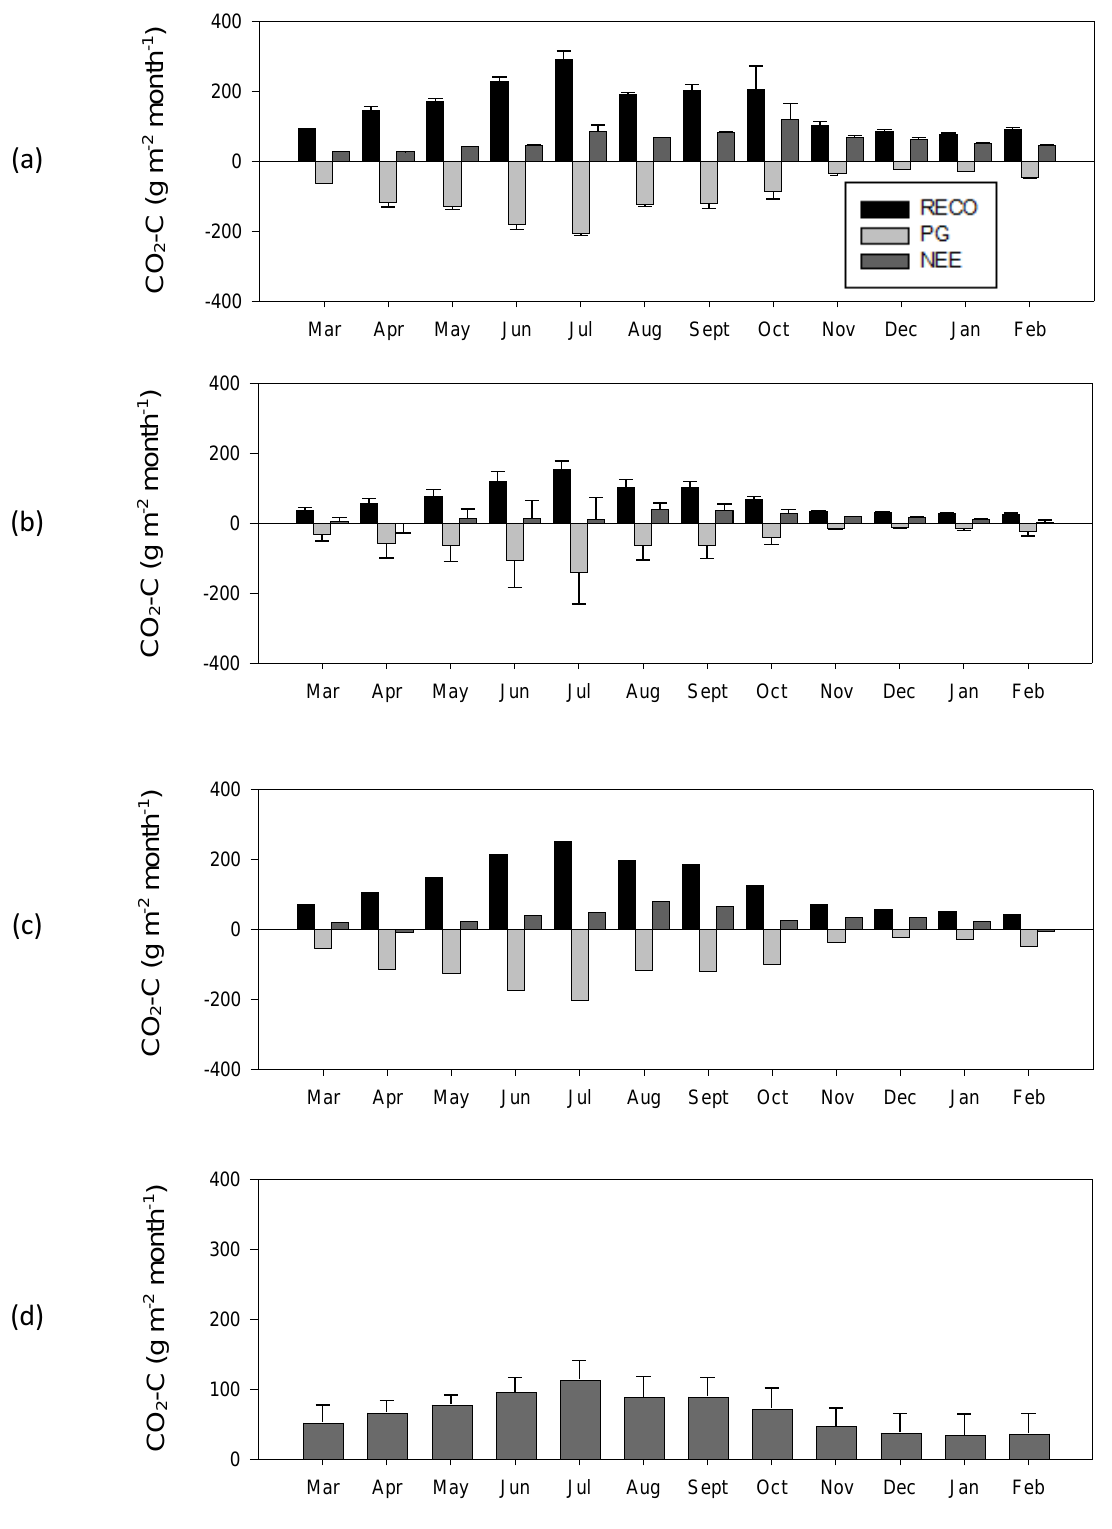
Figure 6. Average monthly modelled gross photosynthesis (P ), ecosystem respiration (R ) and net G eco ecosystem exchange (NEE) as CO -C (g m -2 month -2 ) for (a) Eriophorum - Sphagnum , (b) Cladonia- mosses, 2 (c) Eriophorum and (d) brash sample plots at Scohaboy from March 2014 to February 2015. Positive values indicate losses of CO to the atmosphere while negative values indicate CO uptake by the peatland. Note 2 2 the different scales on the y axes. Error bars indicate standard errors for microsite types represented by more than one sampling